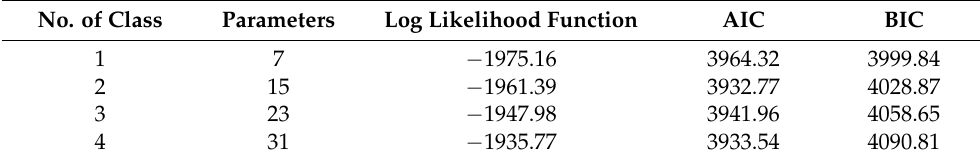
Table 12. Statistics for latent-class regression models ( secure sense ). No. of Class Parameters Log Likelihood Function AIC